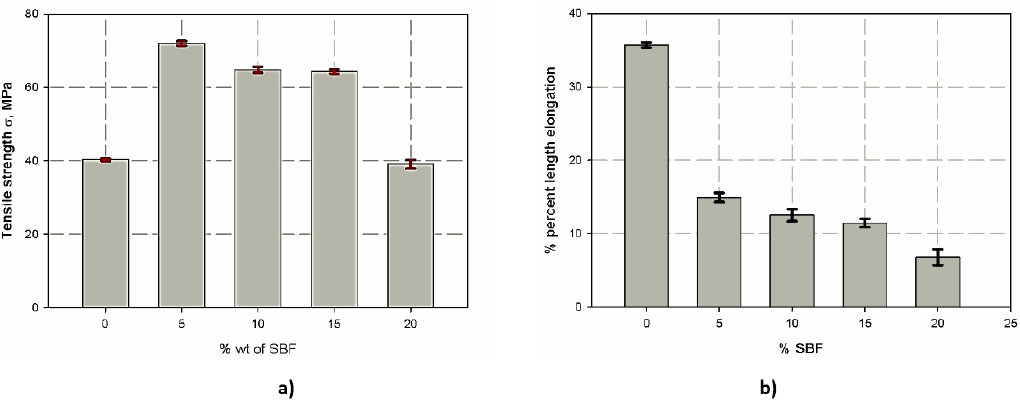
Figure 4. Variation with wt % ( a ) Tensile strength; ( b ) Percent elongation.